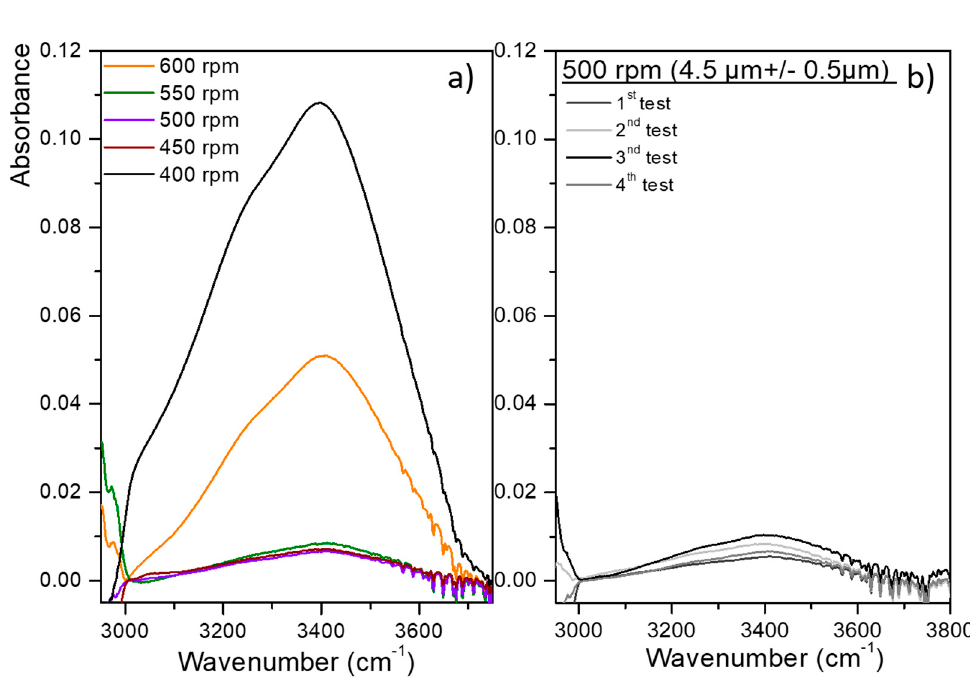
Figure 5. ( a ) MIR-ATR absorption spectra of water for different rotational rates (400–650 rpm)—( b ) MIR-ATR spectra of water in the OH stretching range for four polymer layers (numbered from 1 to 4) deposited using the same deposition parameters, i.e., 500 rpm rotational rate, 500 µL volume of the solution, and rotational time of 30 s.